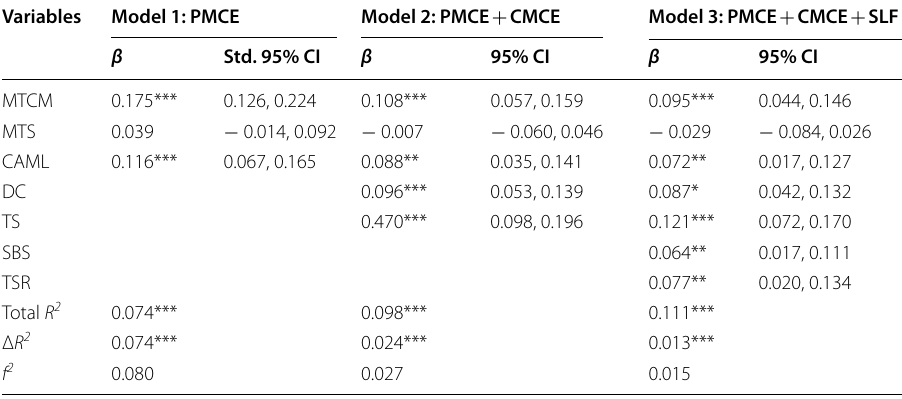
Table 1 School and Classroom Climate Contributions to Mathematics Self-Concept: Hierarchical Regression Model Results in the Aggregated